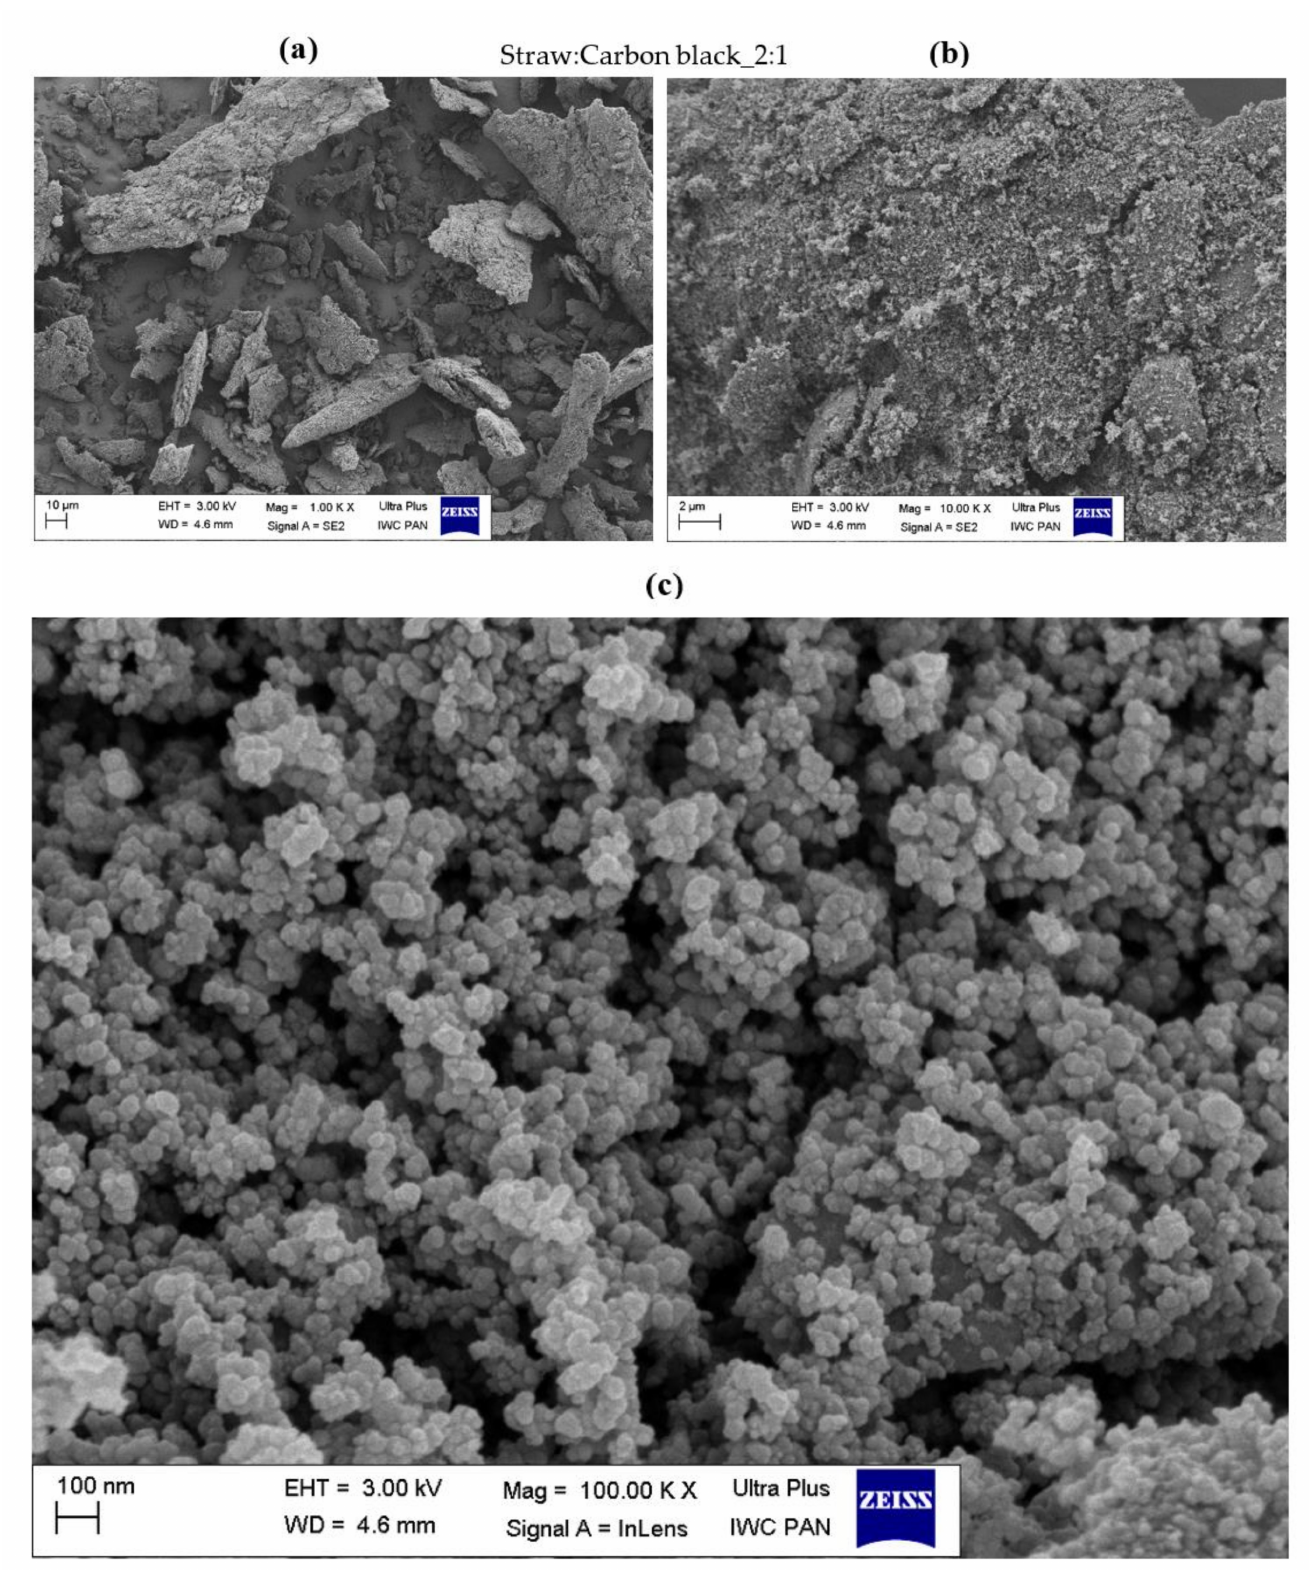
Figure 8. Microscopic images of straw fillers with the addition of carbon black (2:1) at a magnification of ( a ) × 1.00 k, ( b ) × 10.000 k, ( c ) × 100.00